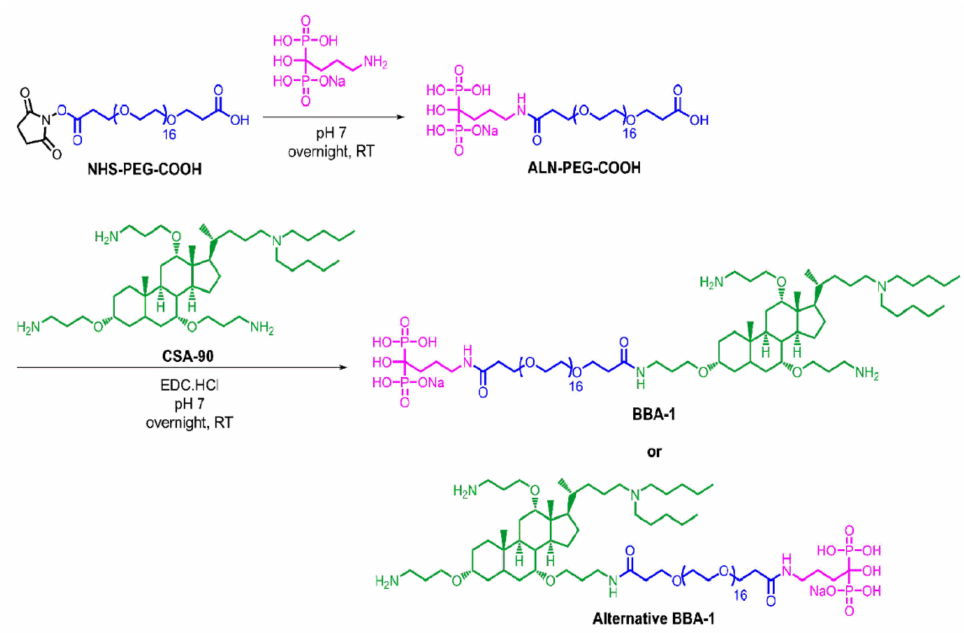
Figure 1. Synthesis of bone-binding antibiotic (BBA-1) by conjugating alendronate (ALN) and cationic selective antimicrobial- 90 (CSA-90) using the NHS-PEG-COOH